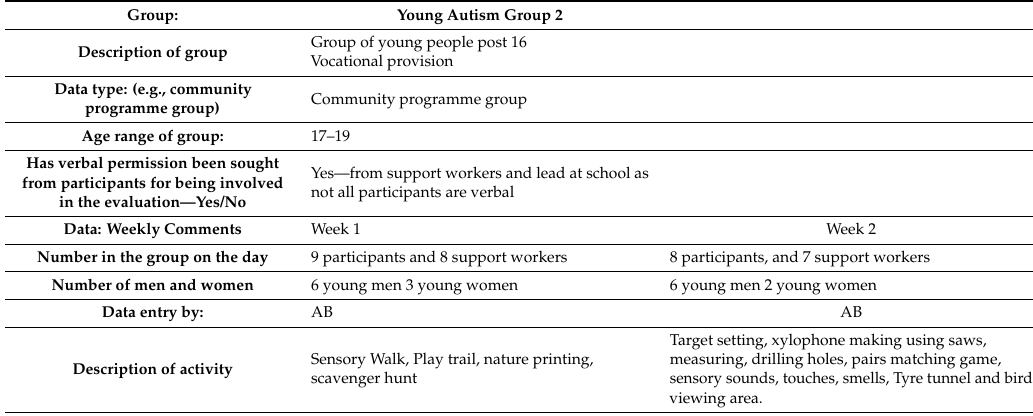
Table A1. The example of data in an Excel spreadsheet from participant observations made by the FCE staff and volunteers. The names of the participants and data gatherers are changed. Data were collected under the ‘five ways to well-being’ themes along with an overall